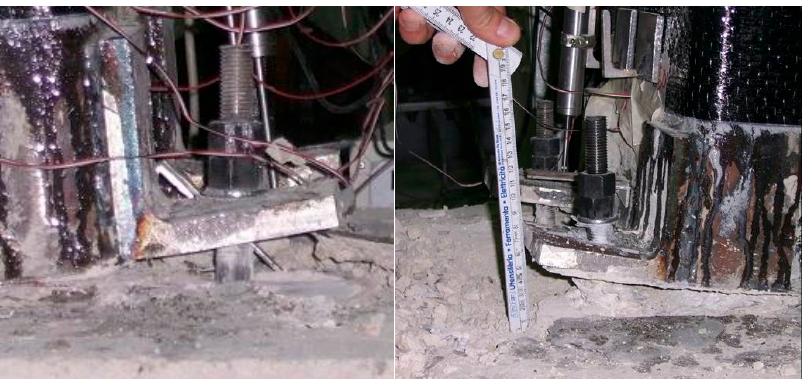
Figure 10. Pull-out of the steel connector from the concrete foundation.